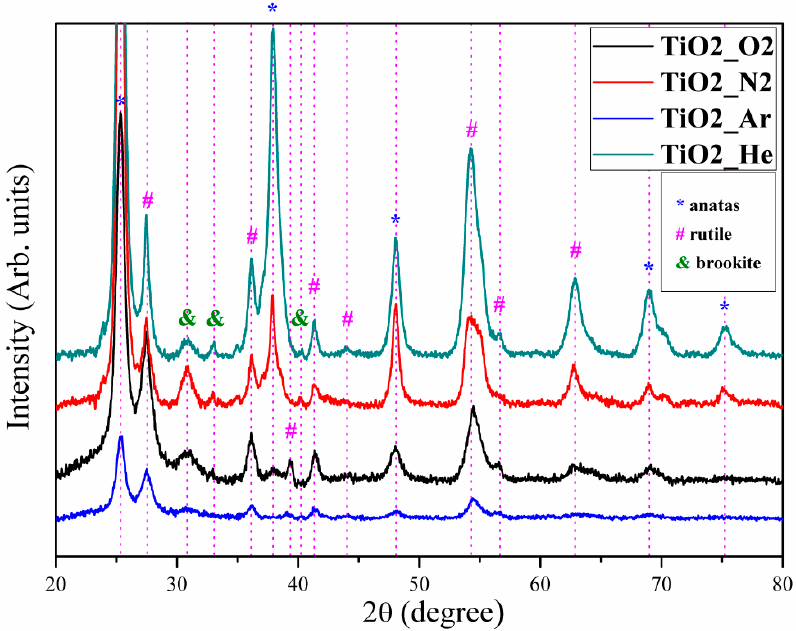
Figure 4. XRD patterns of TiO 2 coatings deposited by PLD in different ambient gases (O 2 , N 2 , Ar, or He).